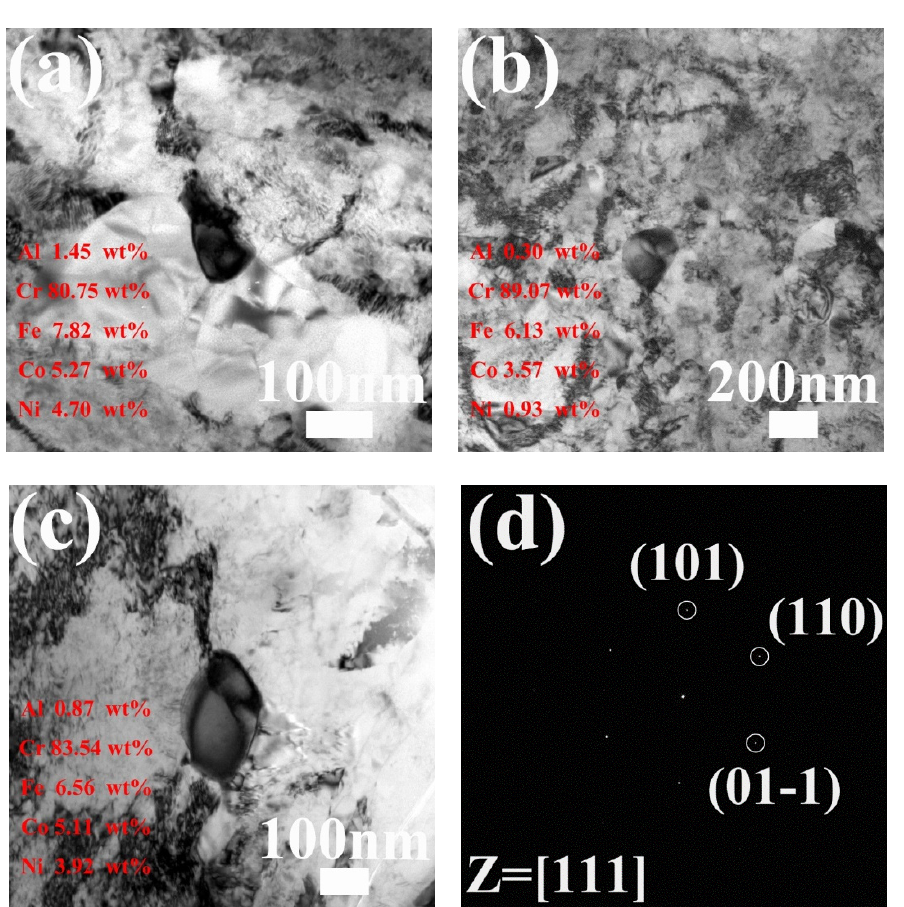
Figure 7. TEM images and corresponding SADP of BCC phase in AR samples: ( a ) AR500 sample; ( b ) AR540 sample; ( c ) AR590 sample; ( d ) corresponding SADP of BCC precipitation in AR540 sam- ple.